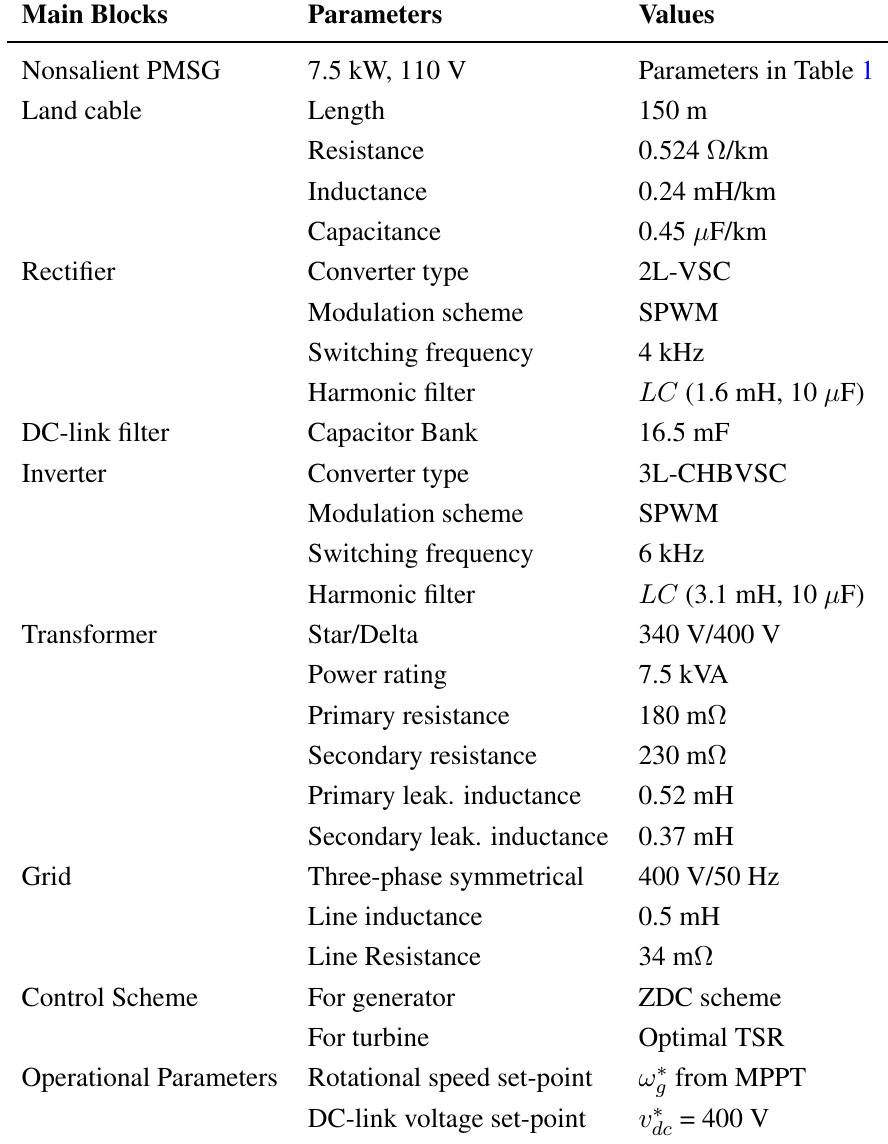
System parameters and operating scheme for the 7.5 kW marine